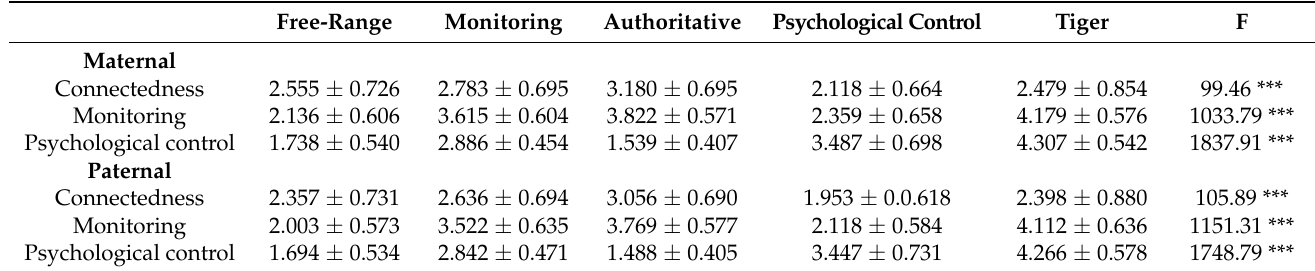
Table 2. Mean comparisons across five latent profiles (Mean ± SD).